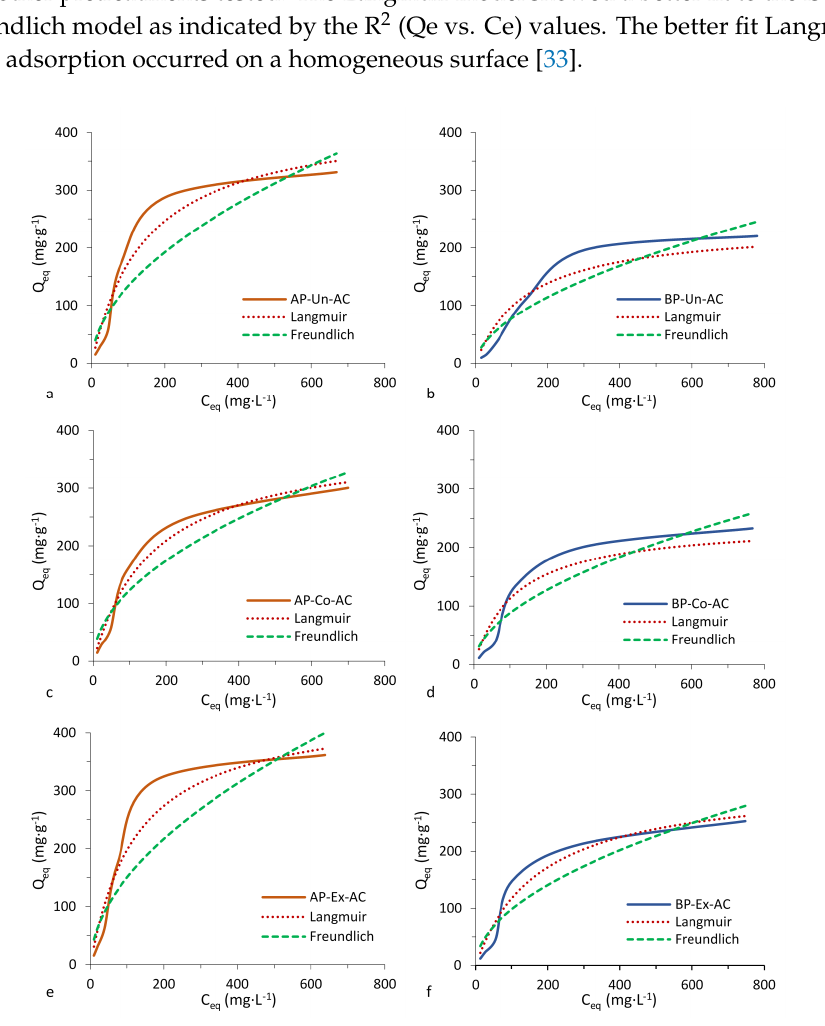
Figure 2. Methylene blue dye adsorption isotherms of piassava activated carbon with and without pretreatments comparing Langmuir and Freundlich curves. AP, Amazon piassava; BP, Bahia piassava; Ch, charcoal; AC, activated carbon; Un, untreated, no pretreatment; Co, Corona electrical discharge pretreatment; Ex, solvent extraction